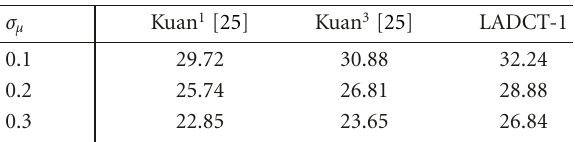
Figure 2: Original SLAR image (a) and the output image after ap- plying LADCT-1 (b). Table 2: PSNR results for Boat, degraded with multiplicative noise, γ = 1.